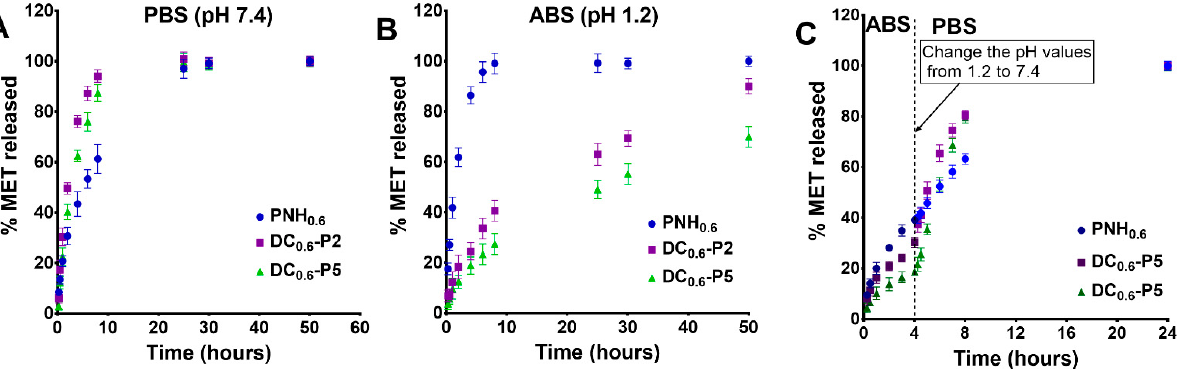
Figure 10. Release kinetics of Met from DC 0.6 hydrogels in PBS (pH 7.4) ( A ) and ABS (1.2) ( B ), at 37 ◦ C.